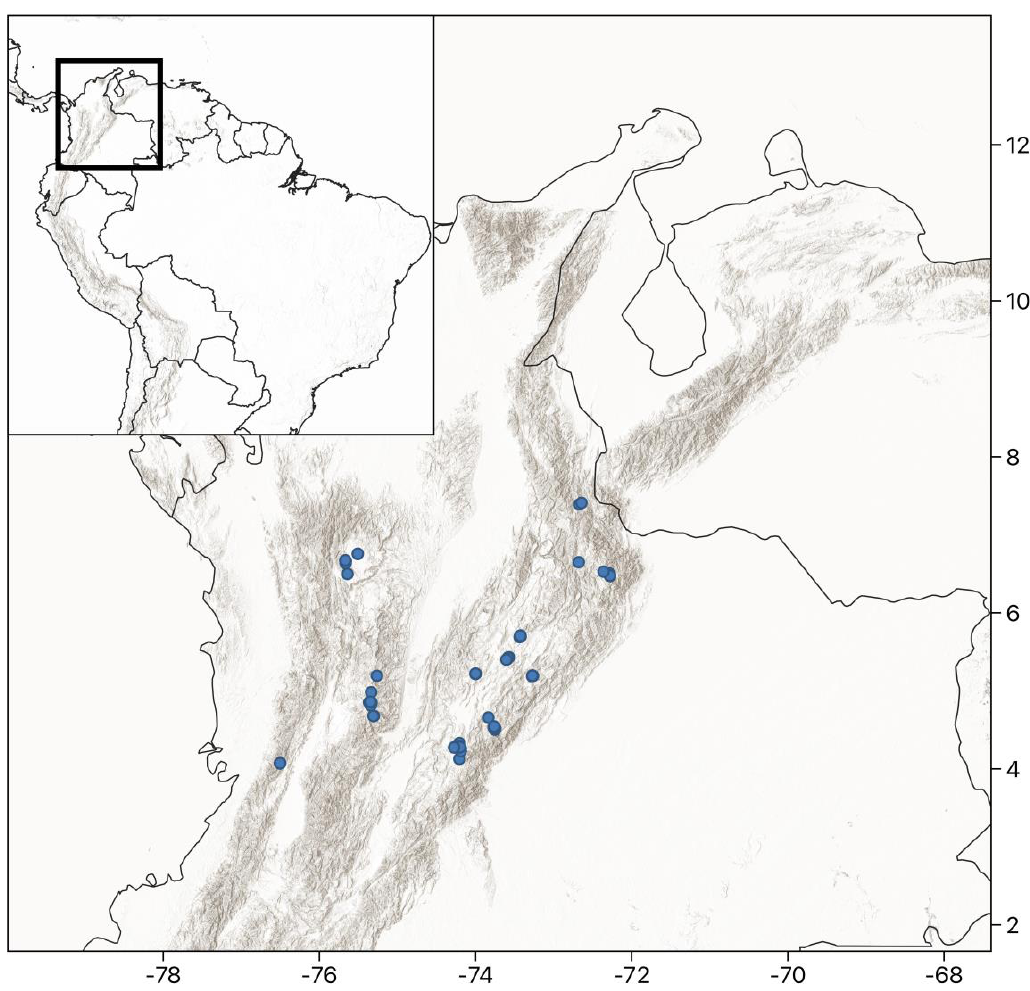
Figure 8. Map of study area in the northern Andes including a shaded digital elevation model (darker areas are higher). Sampled peatlands ( n = 121) are marked with circles. A number of sites are relatively close to each other, and on this, the points overlap.